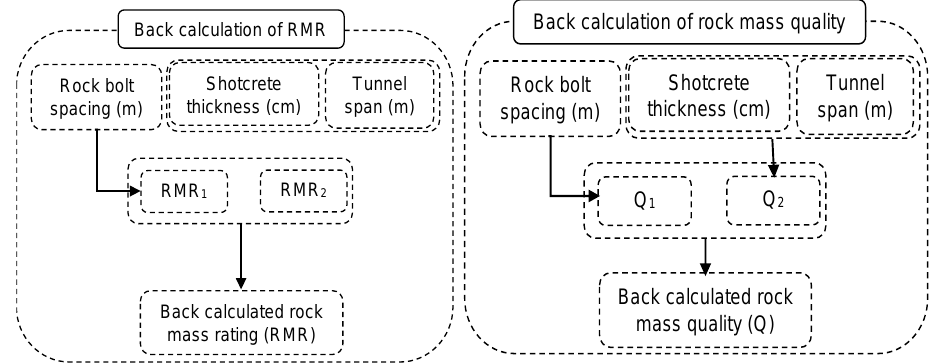
Figure 3. Back-calculation technique for RMR (left) and Q system (right) using tunnel span along with rock-bolt spacing and shotcrete thickness [58].